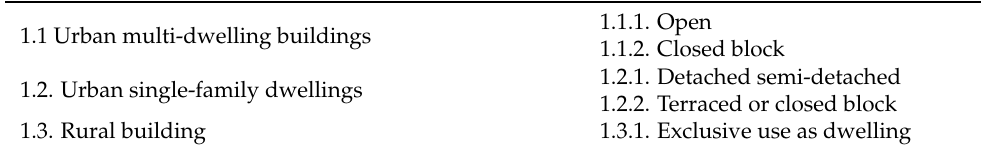
Table 2. Construction types selected 1